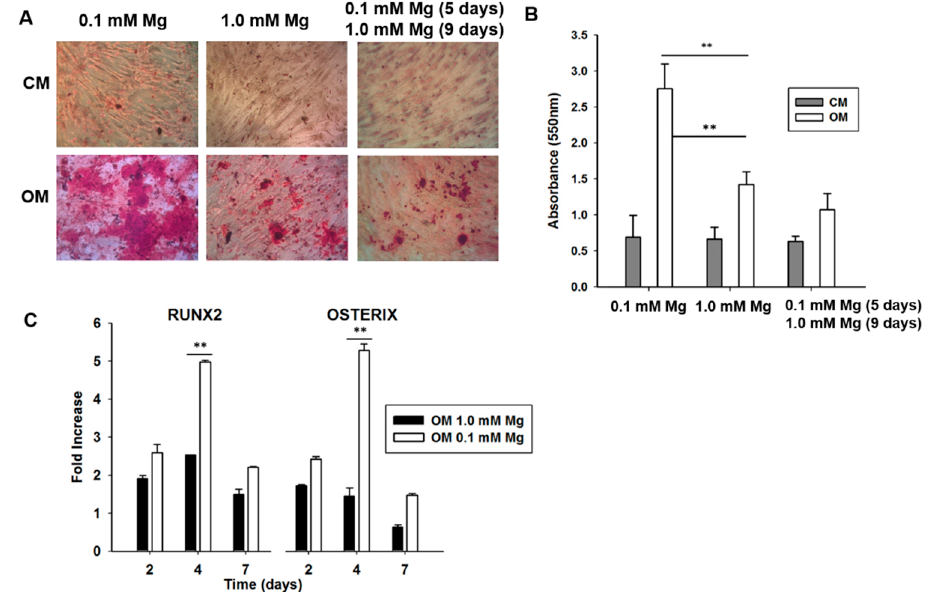
Figure 3. Effect of Mg withdrawal and re-supplementation in differentiating bone marrow mesenchymal stem cells (BM-MSCs). ( A ) BM-MSCs were cultured in 1 mM Mg (middle panel) or in Mg-deprived medium (left panel) and exposed to control medium (CM) or osteogenic medium (OM). BM-MSCs were cultured in Mg-deficient medium for 5 days and in 1 mM Mg for the following 9 days. After 14 days we evaluated the deposition of calcium phosphate in the extracellular matrix by Alizarin Red S staining. Photographs were taken at 10× magnification. ( B ) The absorbance of Alizarin Red S staining was measured at 550 nm. ** p < 0.01. ( C ) BM-MSCs were cultured in 1 mM Mg or in Mg-deprived medium and exposed to CM or OM for 2, 4 and 7 days. Real-time PCR was performed three times, carried out in triplicate, on RNA extracted using primers designed on RUNX2 and Osterix ( OSX ) sequence. All the values were normalized with respect to their controls cultured in CM. ** p < 0.01. Next, we evaluated the expression of two early markers of osteogenic differentiation,